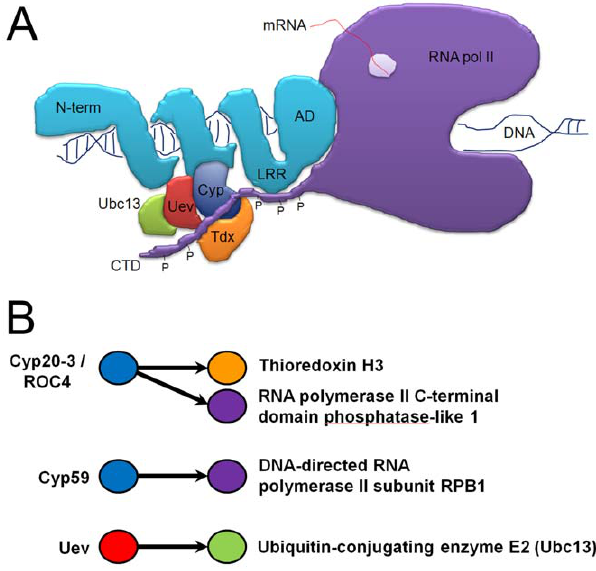
Figure 8. Protein-protein interactions involving cyclophilins and the CTD. (A) Cartoon model of protein-protein interactions illustrating how TAL effectors (PthAs) might associate with components of the host basal transcription machinery. The unfolded CTD of RNA pol II (purple) with phosphorylated heptapeptides (P) may function as a protein scaffold for the assembly of a multiprotein complex, including the citrus CsCyp (blue), CsTdx (orange) and the CsUev/Ubc13 pair (red/ green). The N-terminal (N-term), DNA-binding domain, leucine-rich repeat region (LRR) and activation domain (AD) of PthA are shown in light blue. Upon binding to its target DNA, the effector protein associates with the CsCyp/CsTdx/CsUev/Ubc13 complex through its DNA-binding domain [15], and with the CTD through its LRR. The effector protein then inhibits the PPIase activity of CsCyp causing changes in the phosphorylation status of the CTD, allowing the CTD to recruit other co-factors for the progress of transcription. (B) Schematic representation of protein-protein associations found in an Arabidopsis interactome study, depicting the interactions between ROC4 (Cyp20-3) with the CTD and thioredoxin H3, and between Uev and Ubc13 [39]. The Arabidopsis AtCyp59 is also a CTD interactor [40]. Sweet orange and Arabidopsis proteins sharing similar domains are represented by the same colors in A and B.